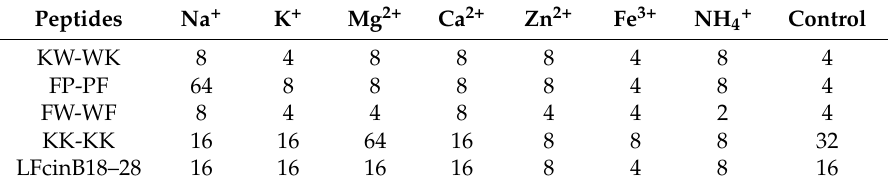
Table 3. MIC values of antimicrobial peptides in the presence of physiological salts.